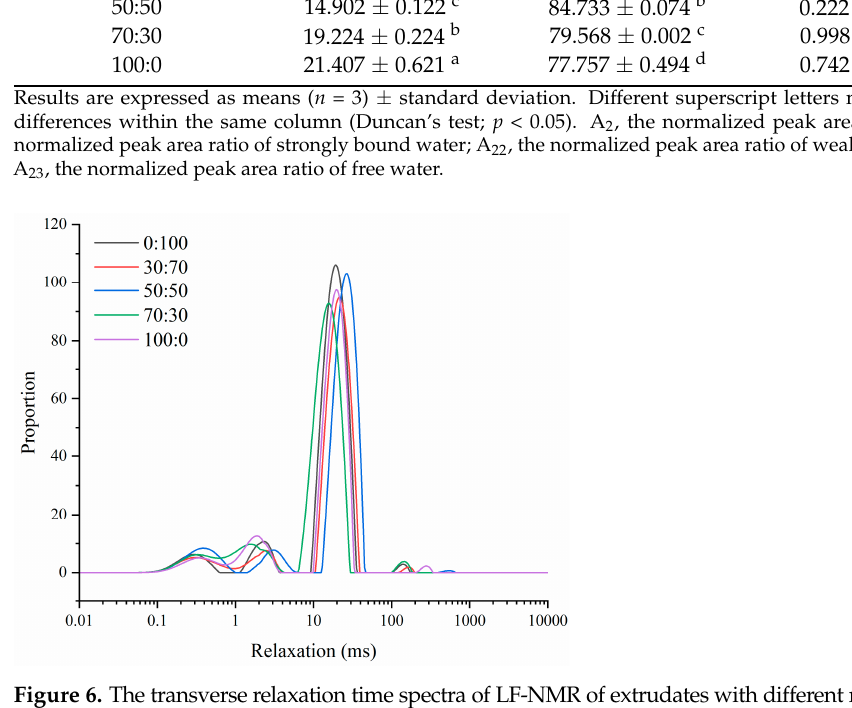
Figure 7. Proton density-weighted images of extrudates at the WG to PPP ratio of 0:100 ( a ); 30:70 ( b ); 50:50 ( c ); 70:30 ( d ); and 100:0 ( e ).